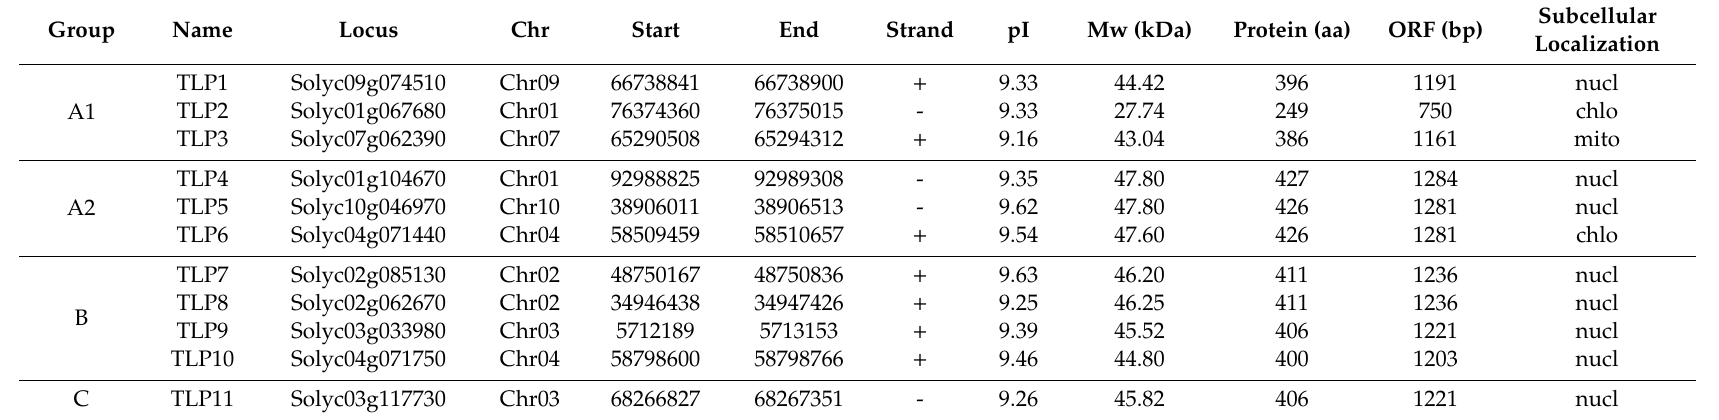
Table 1. Basic Information of tubby-like proteins (TLPs) in